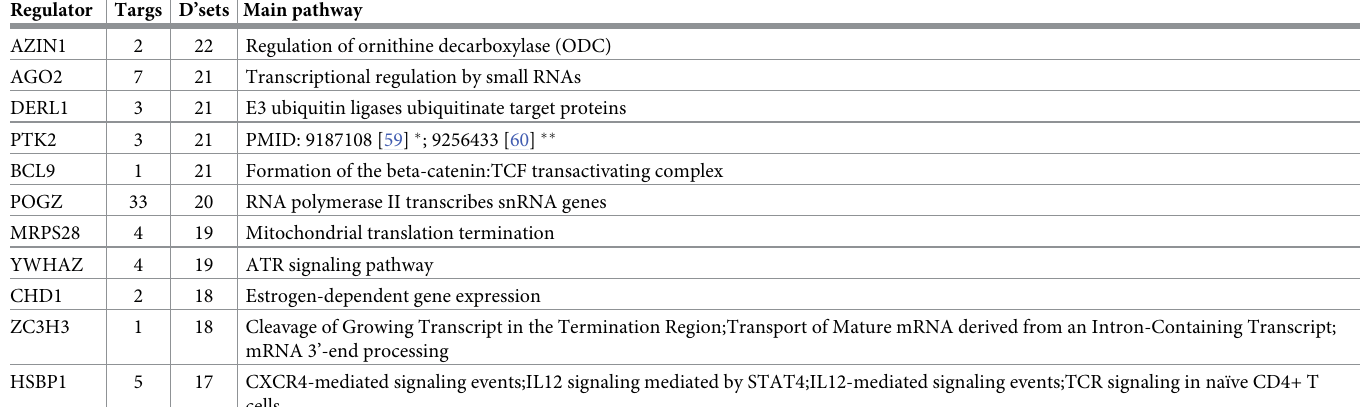
Table 2. Regulatory genes with self aCGH/expression correlation in the greatest number of datasets. Regulator Targs D’sets Main